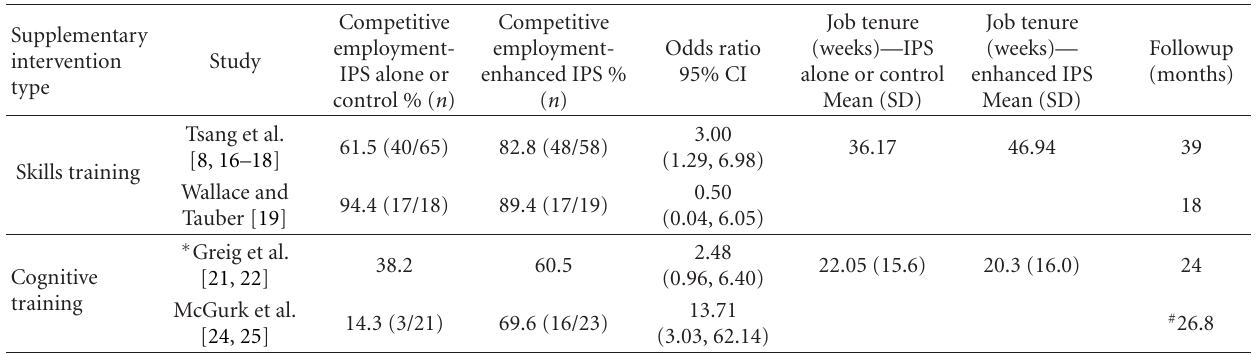
Table 2: Cumulative employment rates and job tenure across